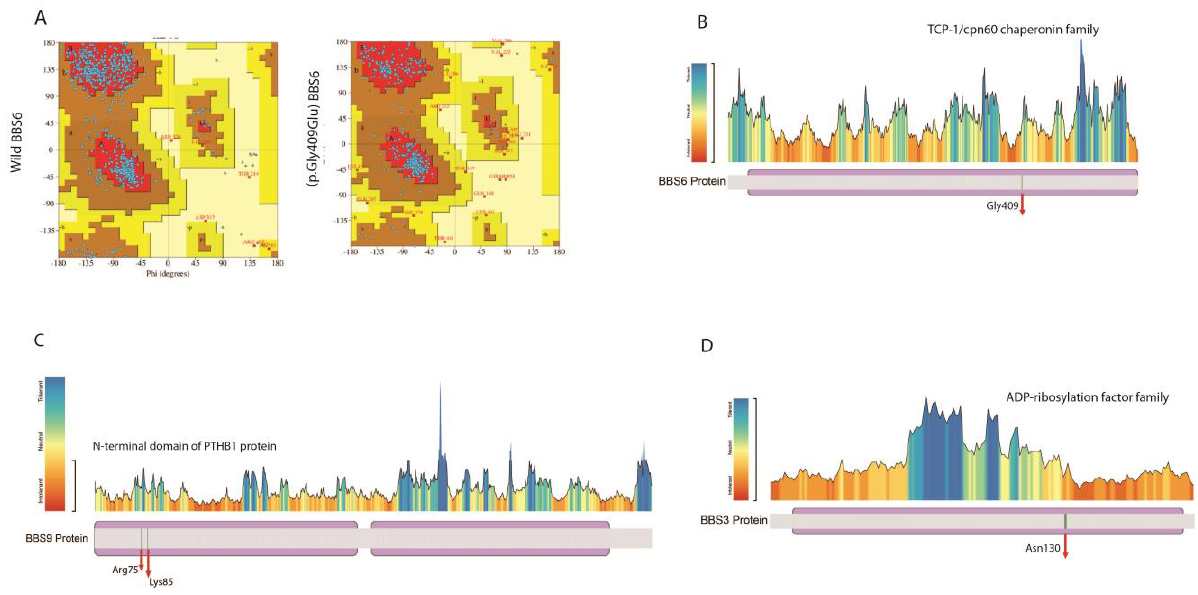
Figure 3. Protein modeling and bioinformatics analysis of identified variants. ( A ) Ramachandran plot for wild-type and mutated residues of the BBS6/MKKS gene. ( B ) MetaDome health map showing BBS6/MKKS residue. ( C ) MetaDome health map showing BBS9 residues. ( D ) MetaDome health map showing BBS3 residue.